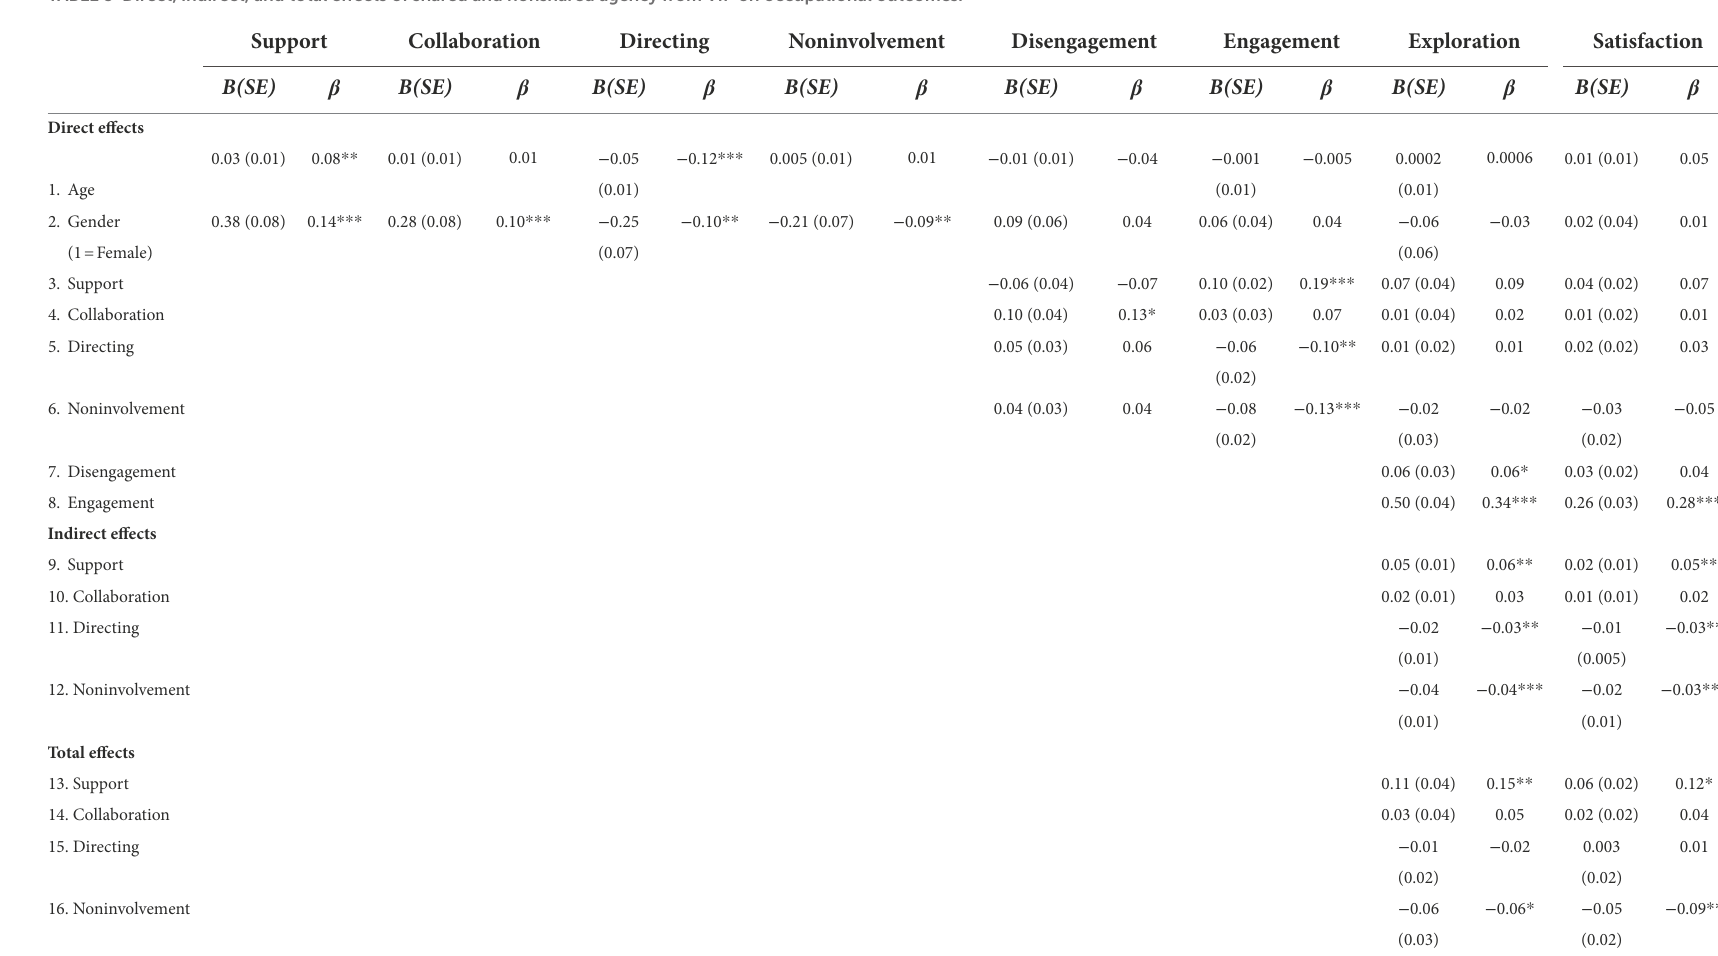
TABLE 5 Direct, indirect, and total effects of shared and nonshared agency from VIP on occupational outcomes.